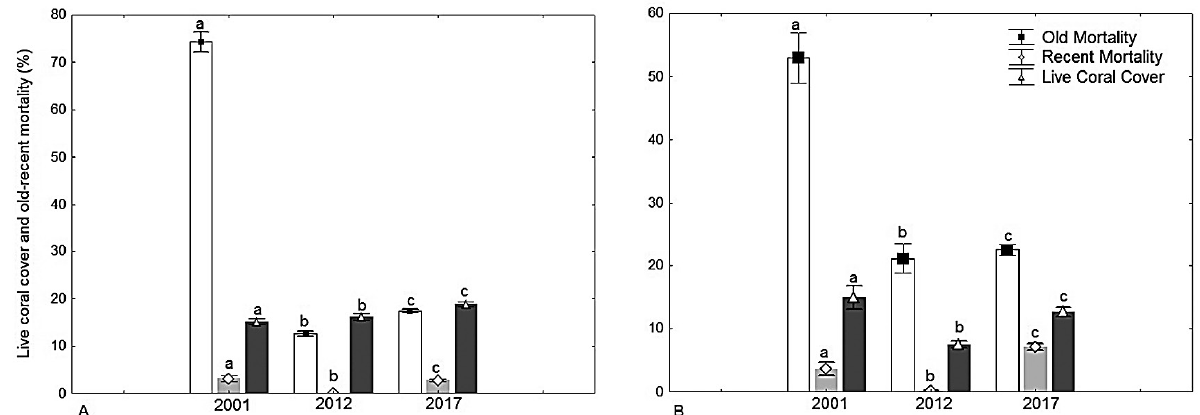
Fig. 5. – Old mortality (OM), recent mortality (RM) and live coral cover (%) on the fore reef (A) and reef crests (B) in 2001, 2012 and 2017. A: OM (df=2, p-value <2.2e-16), RM (df=2, p-value <2.2e-16), live coral cover (df=2, p-value=9.802e-06). B: OM (df=2, p-value=2.058e-12), RM (df=2, p-value <2.2e-16), live coral cover (df=2,